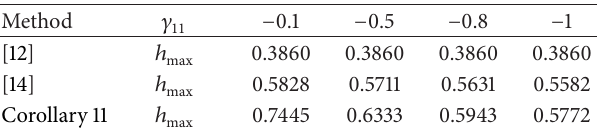
Table 3: The maximum allowable upper bound for different 𝛾 11 and = 1.5 . ℎ 𝑑